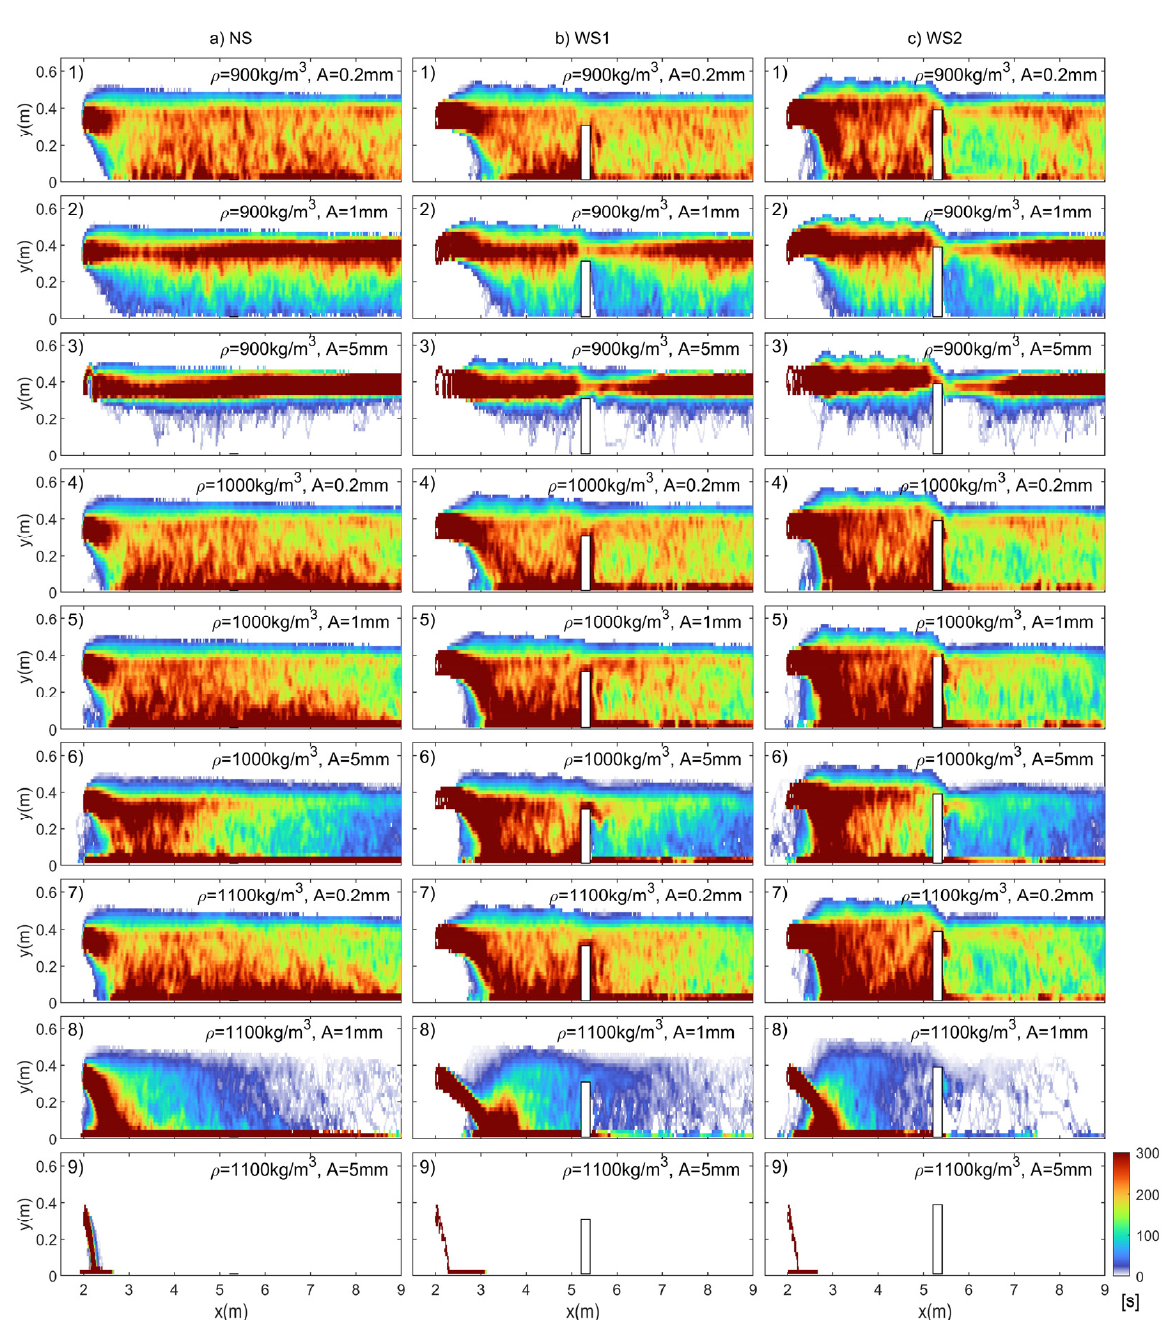
Figure 7. Residence time t r in seconds accumulated at each grid cell for all particles during simulation time. x- and y-axes are the distances from the origin shown in Figure 1.